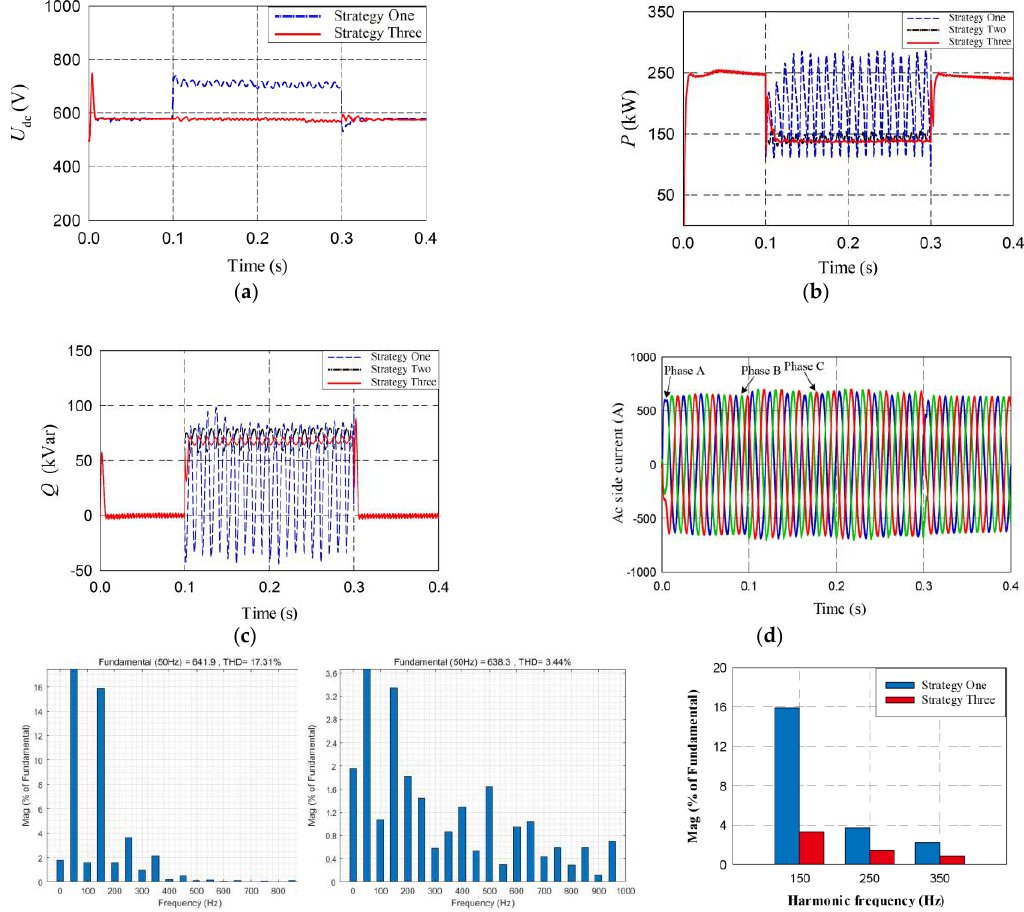
Figure 17. Operating characteristics and waveforms in case of phase A voltage sag under different control strategies: ( a ) DC bus voltage; ( b ) Active output power of the inverter; ( c ) Comparison of output reactive power of inverter; ( d ) Grid current under strategy Three; ( e ) The THD ( i.e., total harmonic distortion) of grid current under strategy One; ( f ) The THD of grid current under strategy Three; ( g ) Harmonic currents under strategy One and strategy Three.